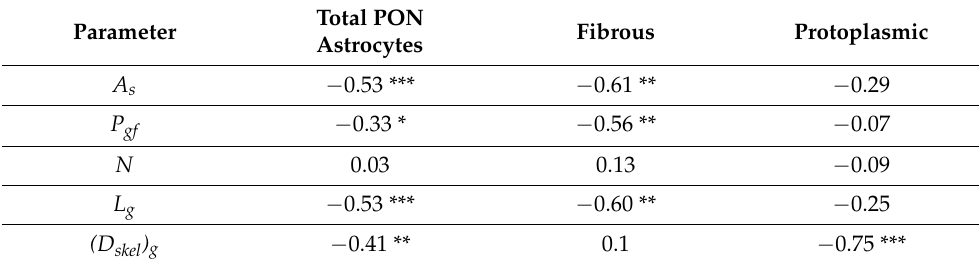
Table 3. The Pearson correlation coefficients between the selected parameters and age. Total PON Fibrous Protoplasmic Parameter Astrocytes